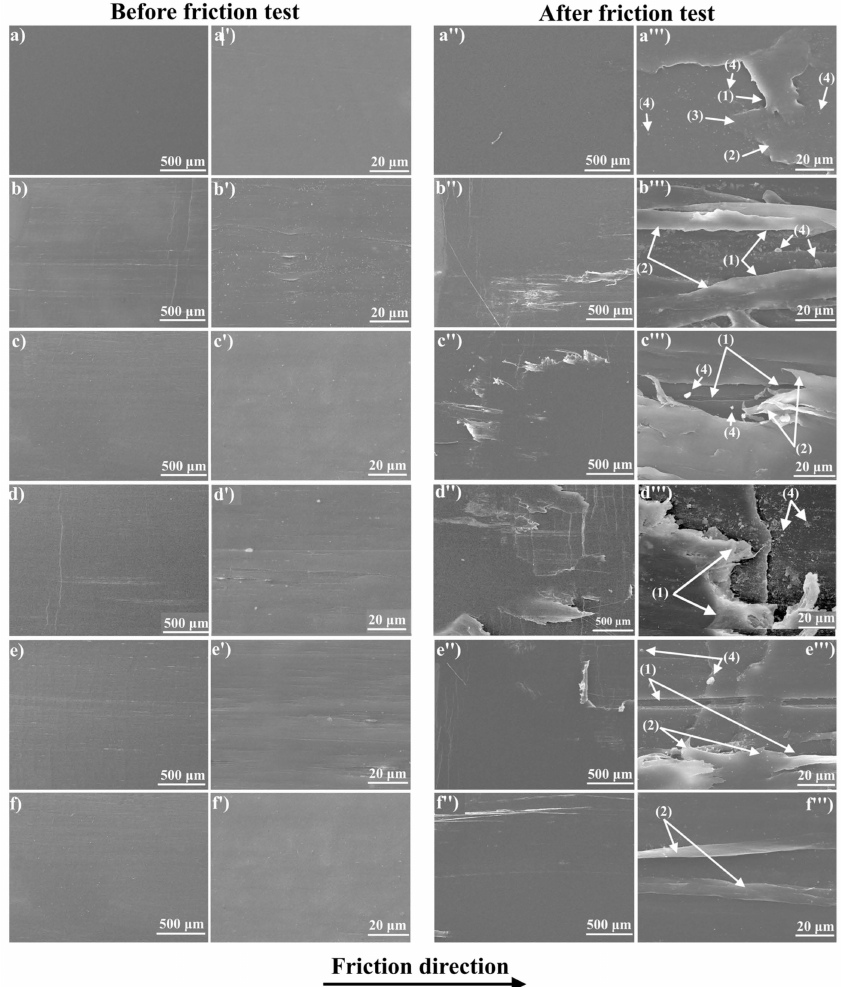
Figure 11. SEM micrographs of the UHMWPE films before and after friction tests, ( a,a’,a”,a”’ ) isotropic UHMWPE, ( b,b’,b”,b”’ ) virgin oriented UHMWPE, ( c,c’,c”,c”’ ) oriented UHMWPE/1.0% PE-wax, ( d,d’,d”,d”’ ) oriented UHMWPE/1.0% PE-wax/0.01% GNP/PANI, ( e,e’,e”,e”’ ) oriented UHMWPE/1.0% PE-wax/0.5% GNP/PANI, and ( f,f’,f”,f”’ ) oriented UHMWPE/1.0% PE-wax/2.0% GNP/PANI; (1) abrasive wear, (2) delamination (waves), (3) elongated polymer particles, and (4) wear particles. a–f: samples before friction with a magnification of 500 µ m, ( a’ – f’ ): samples before friction with a magnification of 20 µ m, ( a” – f” ): samples after friction with a magnification of 500 µ m, ( a”’ – f”’ ): samples after friction with a magnification of 20 µ m. All samples were obtained by first thermal orientation